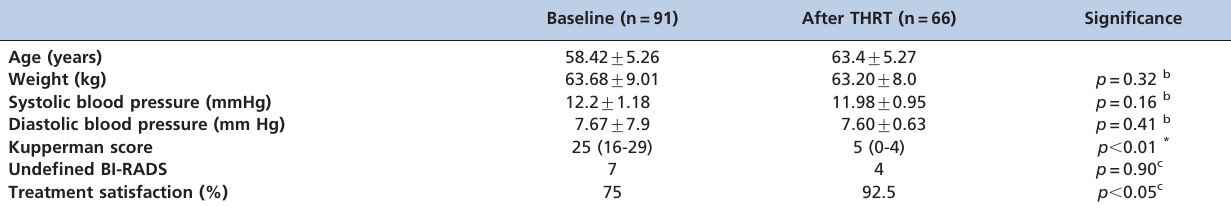
Table 1 - Clinical and anthropometric variables and post-menopausal symptoms of women after 0 (baseline) and 60 months of